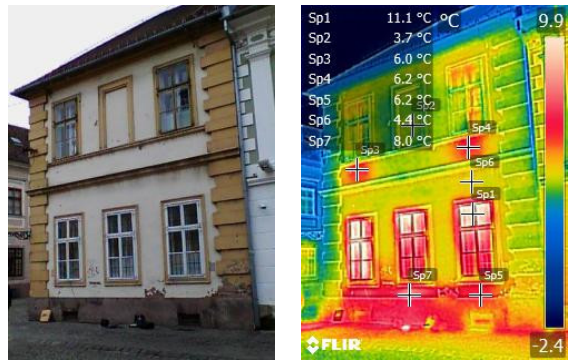
Figure 16. Thermogram of the whole building. Table 3. Emission values for typical building materials [29].